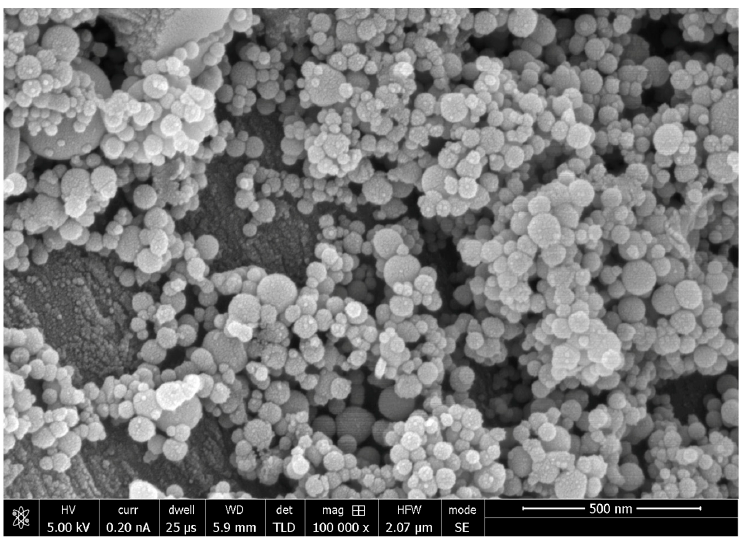
Figure 1. SEM image of HA nanoparticles. These nanoparticles on SEM showed a uniform round shape in mostly agglomerated form with few isolated particles.